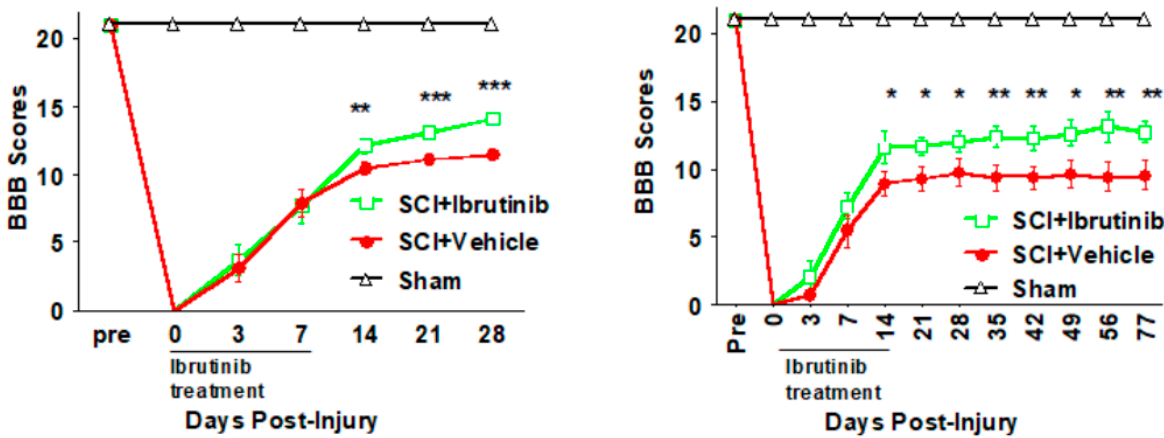
Figure 6. Effects of Ibrutinib post-treatment on locomotor function after SCI. ( Left panel ): Acute treatment with Ibrutinib improved locomotor function after SCI. The 6 mg/kg/day of seven days IP treatment with Ibrutinib resulted in improved locomotor function, measured by BBB scores, up to 28 days after contusive SCI compared to vehicle treated controls. ( Right panel ): Prolonged treatment with Ibrutinib for two weeks improved long-term locomotor function after SCI. The prolonged Ibrutinib (6 mg/kg/day for 14 days) resulted in long-term improved locomotor function, measured by BBB scores, up to 11 weeks after contusive SCI compared to vehicle-treated controls. Contusive SCI was produced using the Infinite Horizons impactor, 180 kdyn setting at T10. Data were presented as mean ± SEM and analyzed with repeated measures ANOVA followed by Bonferroni post-hoc analysis, * p < 0.05, ** p < 0.01, and *** p < 0.001, Ibrutinib treatment vs. vehicle treatment, n = 10 per group.